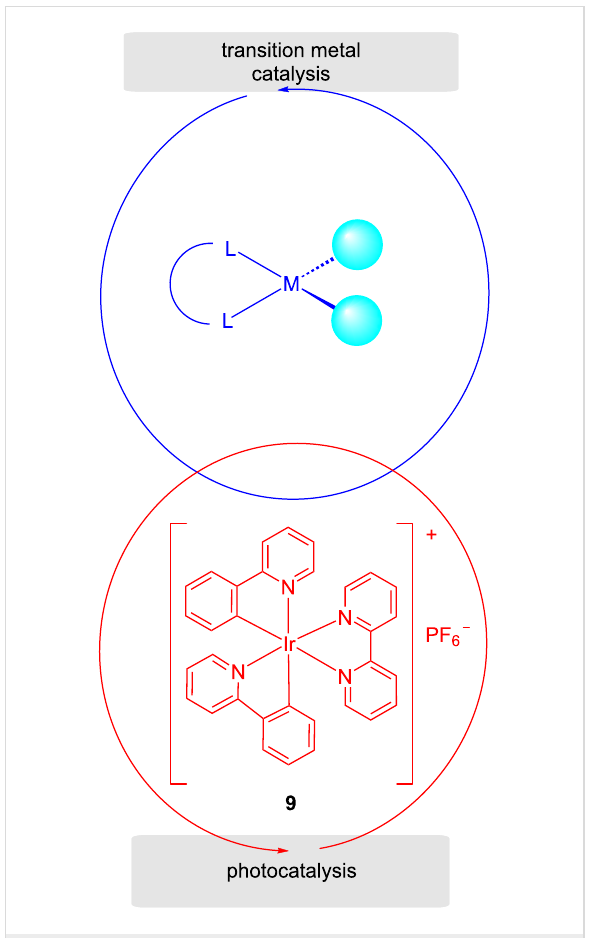
Figure 5: Schematic representation of the combination of photoredox catalysis and transition metal catalysis.